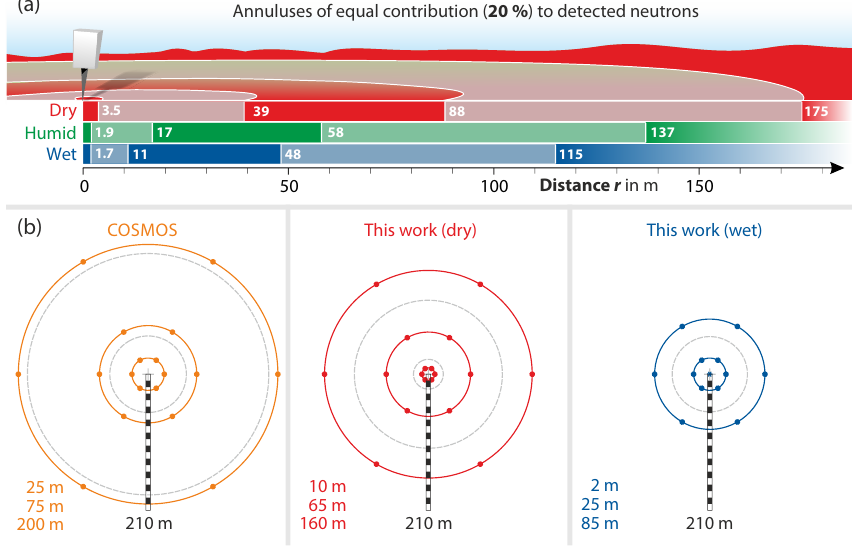
Figure 11. (a) Illustration of regions of equal contribution (20% quantiles) to the neutron signal for three climates, h ={ 2, 7, 20 } gm − 3 , θ v ={ 2, 20, 50 } %. (b) The COSMOS standard sampling scheme based on W conv r , compared to two exemplary three-radii schemes based on the revised function W r ∗ for dry ( h = 1gm − 3 , θ v = 1%), and wet ( h = 10gm − 3 , θ v = 40%) conditions. Circles represent the borders of the 33% quantiles, r i (grey, dashed), and arbitrary sampling distances R i within these annuluses (colored,